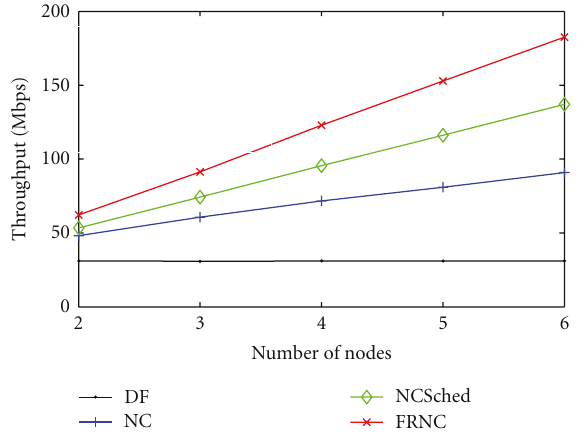
Figure 10: Throughput achieved by di ff erent schemes on the broadcast channel, e ff ect of the number of nodes. (simulation results, largest constellation is 256